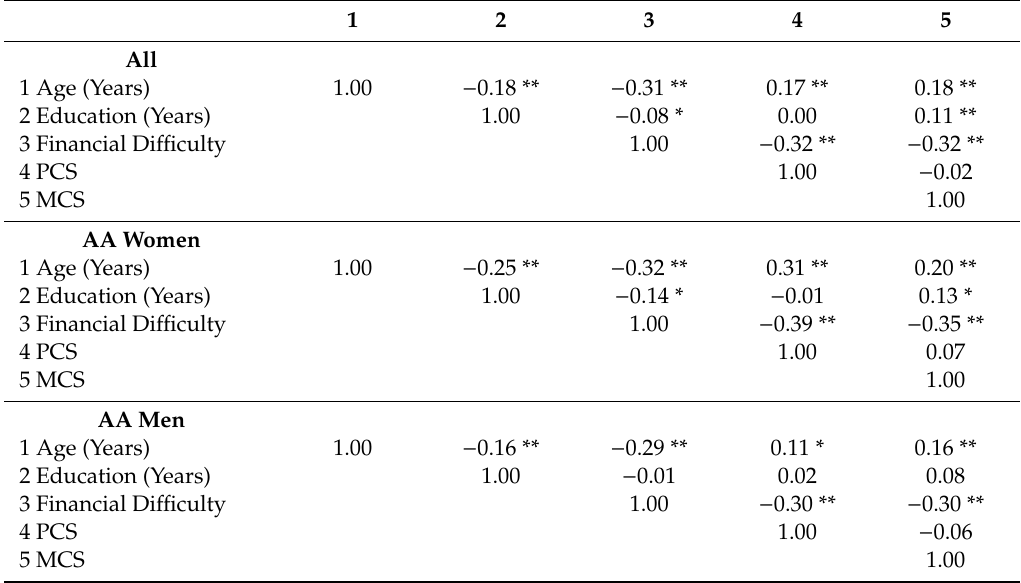
Table 2. Bivariate correlation matrices in the pooled sample and by gender.